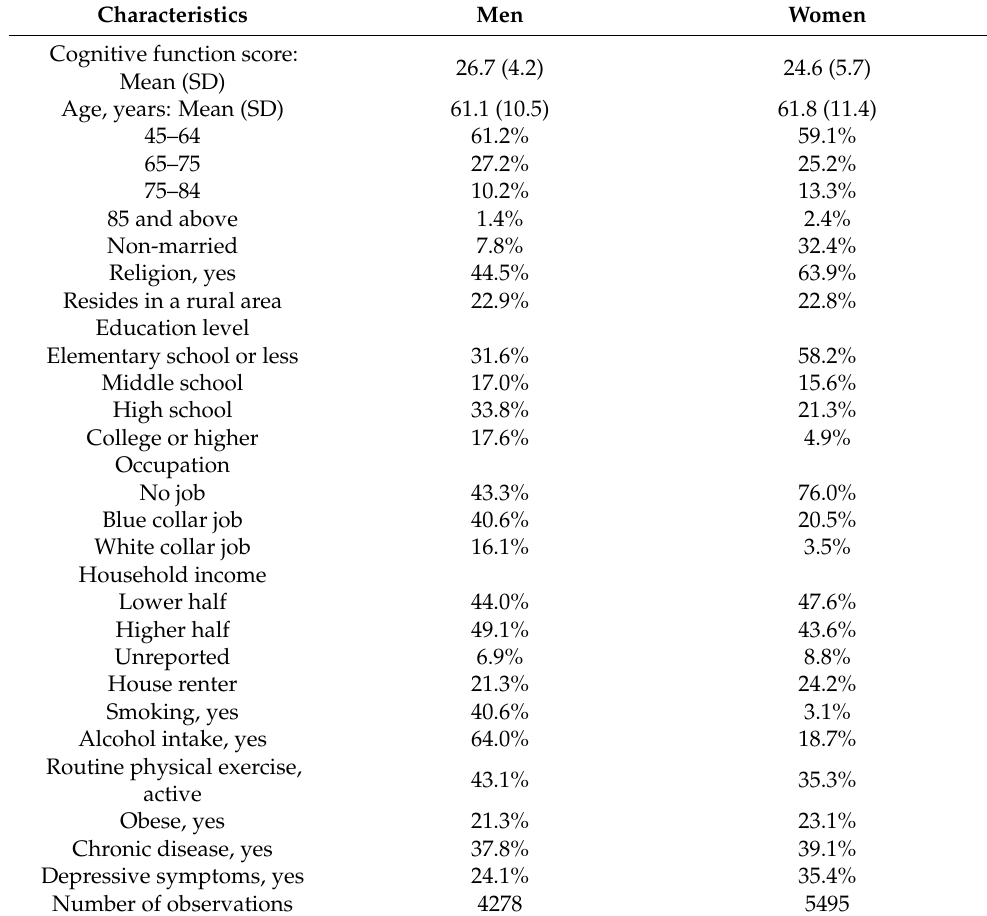
Table 1. The characteristics of sample participants by gender at the baseline (Wave 1). Characteristics